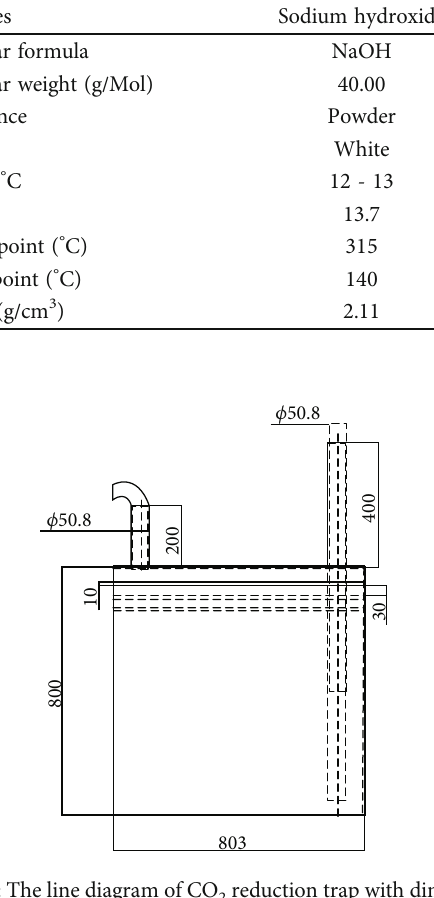
reduction trap. 2